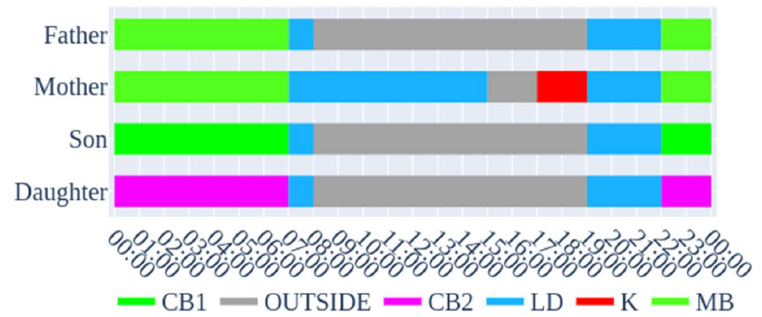
Figure 4. Occupancy schedule of family members in the selected building.